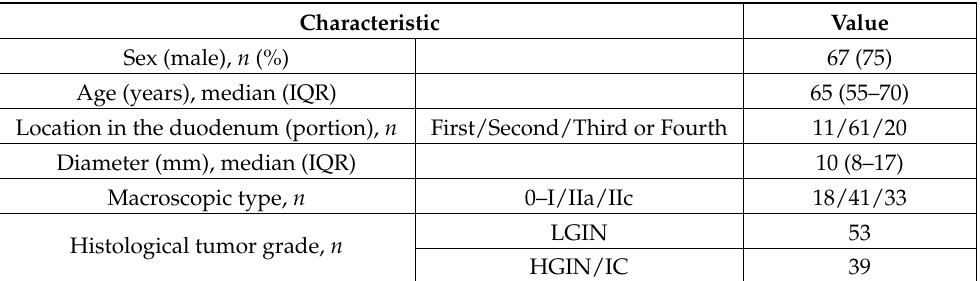
Table 1. Patient and tumor characteristics (89 patients with 92 SNADETs).